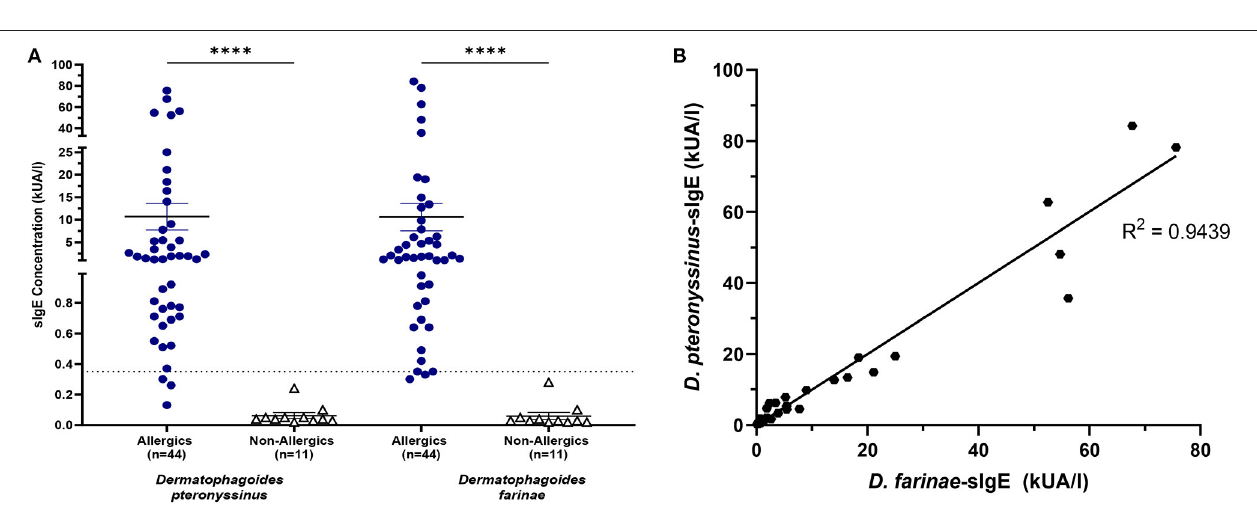
Frontiers in Allergy |